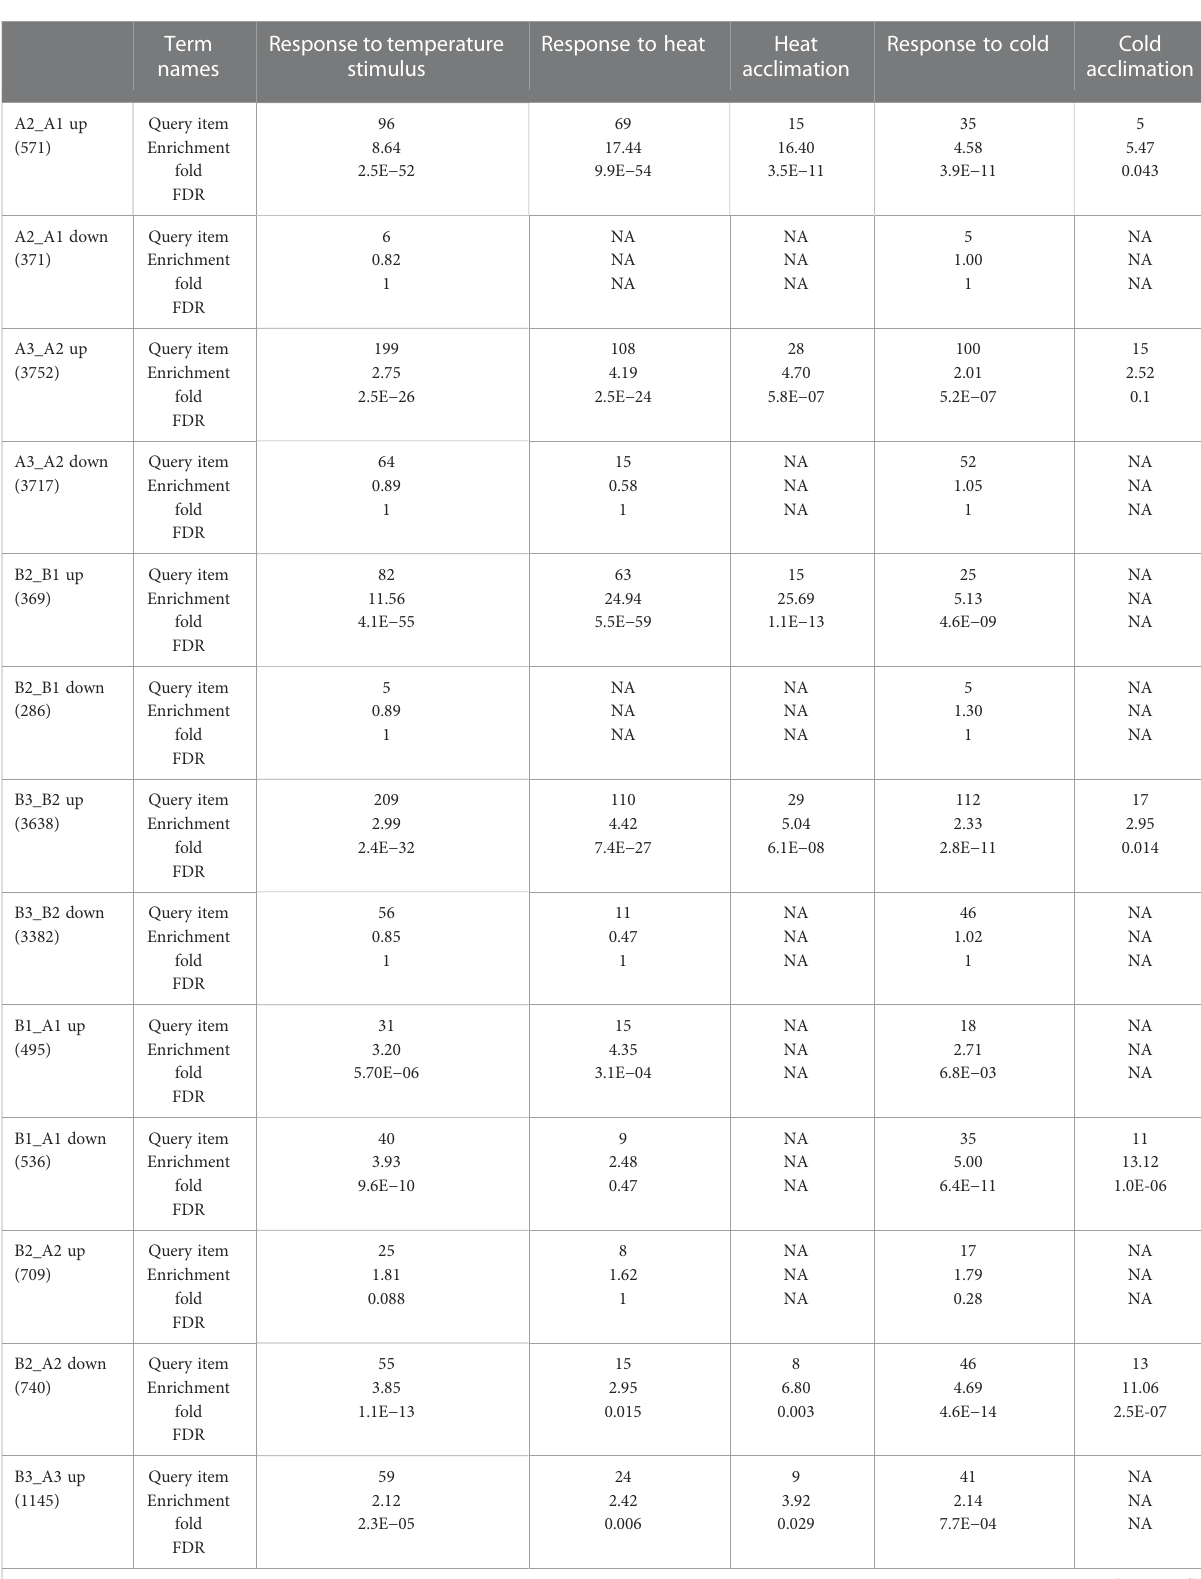
TABLE 1 Genes of response to temperature stimulus and response to heat are enriched in differentially expressed genes (DEGs) between different times of heat treatment or different